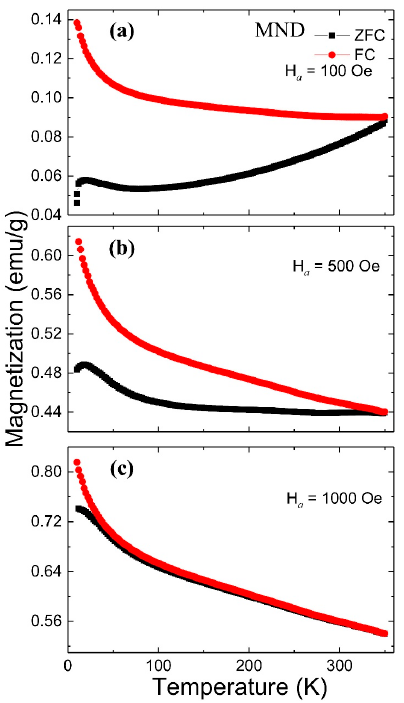
Figure 3. ZFC-FC temperature-dependent magnetization curve from MND measured at ( a ) 100 Oe, ( b ) 500 Oe, and ( c ) 1000 Oe.